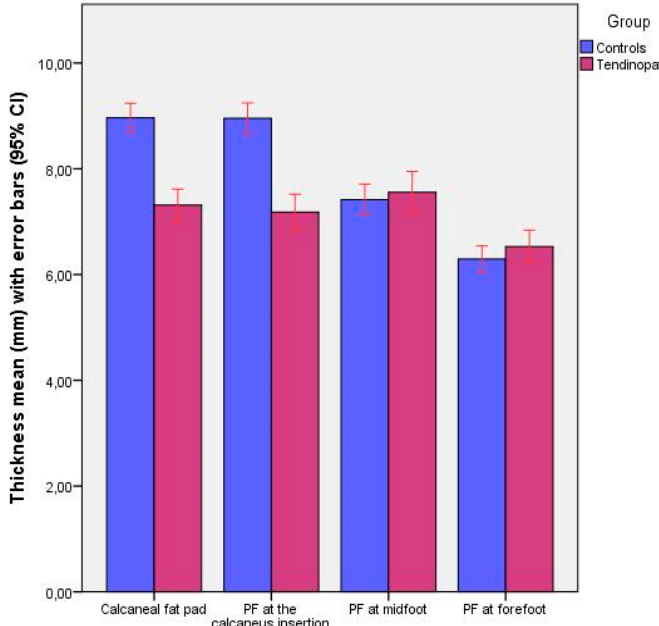
Figure 3. Bar graphs completed with the 95% CI to illustrate the thickness differences of calcaneus fat pad and plantar fascia at the calcaneus insertion, midfoot and forefoot between patients with chronic non-insertional Achilles tendinopathy and controls.